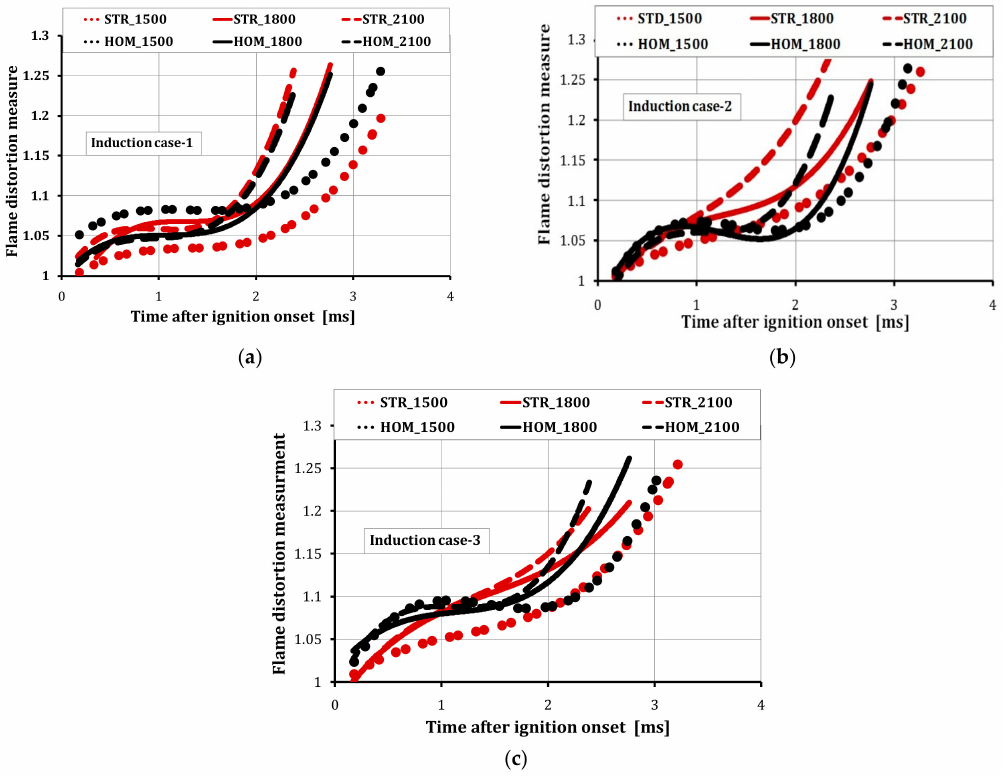
Figure 8. Flame distortion for case 1, case 2 and case 3 induction strategies for stratified and homogeneous charge combustions at variable engine speeds. ( a ) Induction case 1; ( b ) Induction case 2; ( c ) Induction case